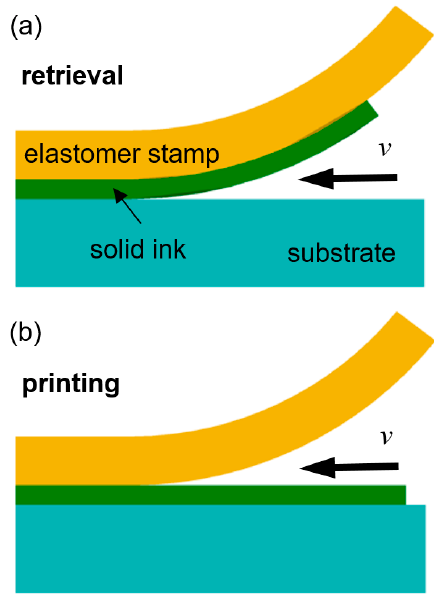
Figure 2. Schematic diagram of retrieval ( a ) and printing ( b ) of a solid ink during transfer printing using an elastomer stamp [36].